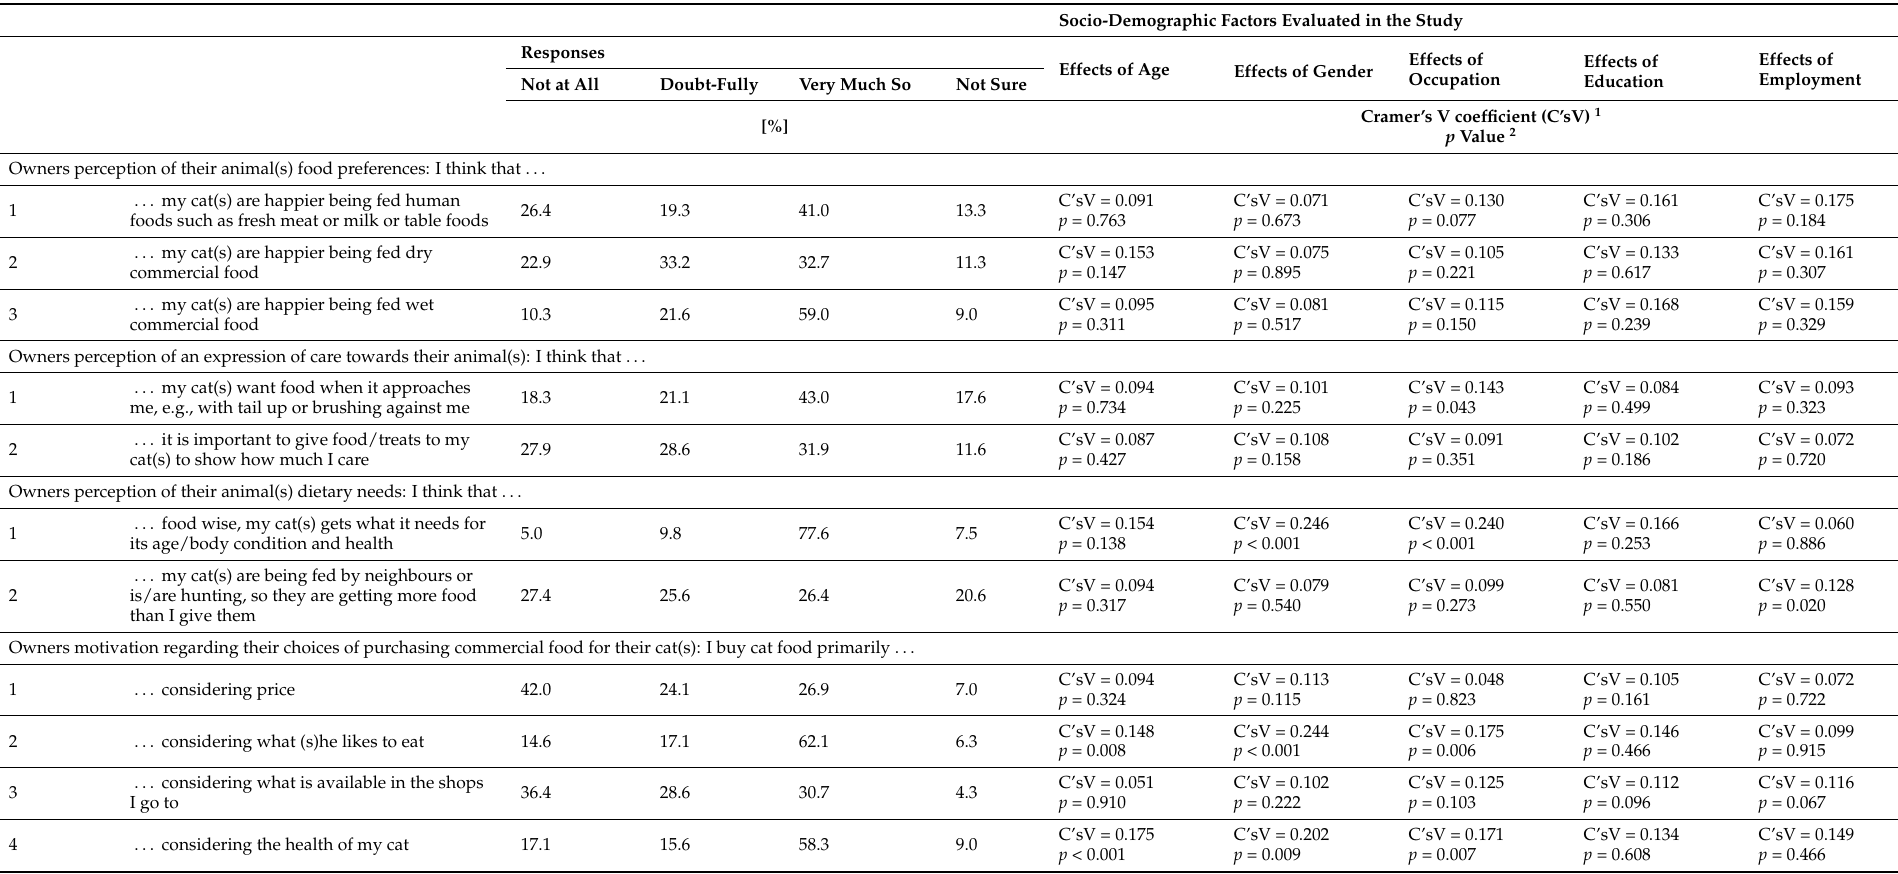
Table 6. Owners attitude of cats dietary preferences, needs and the drivers of shopping for cat food. A full set of cross-tabulated results is shown in Supplementary Materials (Table